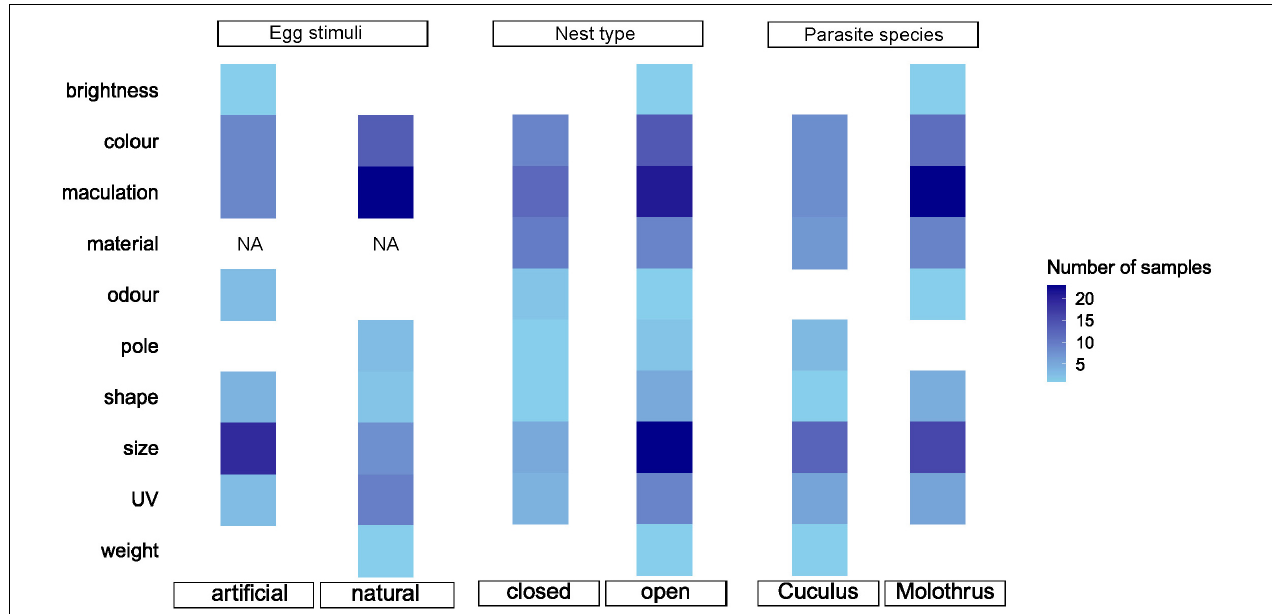
FIGURE 5 | A heat map showing number of samples (number of effect size reports) in our meta-analysis dataset. Blank squares represent no experiments available to be included in our data set for a particular treatment. NA, treatment does not exist in our